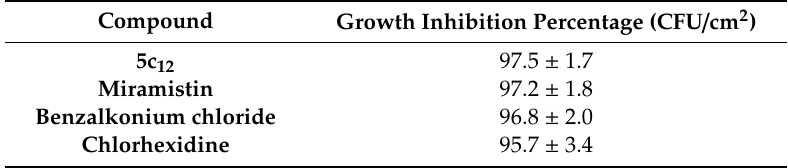
Table 7. In vivo antibacterial e ffi cacy (Mean ± SD) of 0.2% aqueous solution 5c 12 , miramistin, benzalkonium chloride and chlorhexidine in a rat skin model, n =